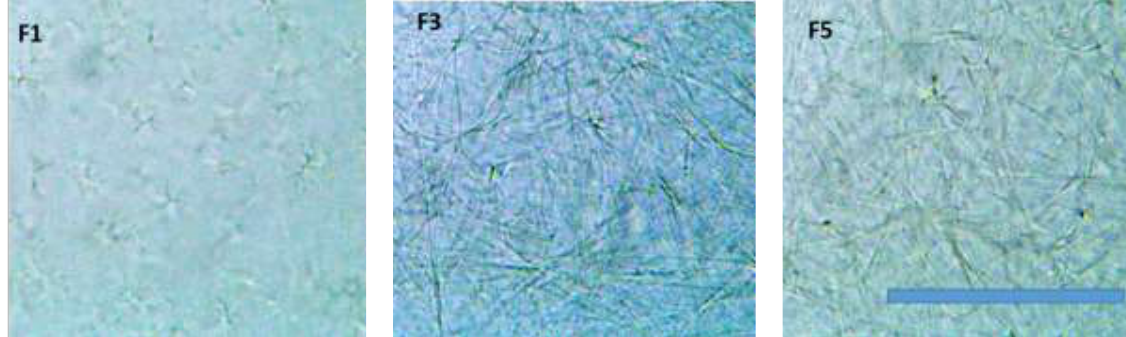
Figure 3. Optical images of selected HOA formulations F1, F3 and F5 in SO organogels as the images taken using X40 magnification and the magnification bar is 50